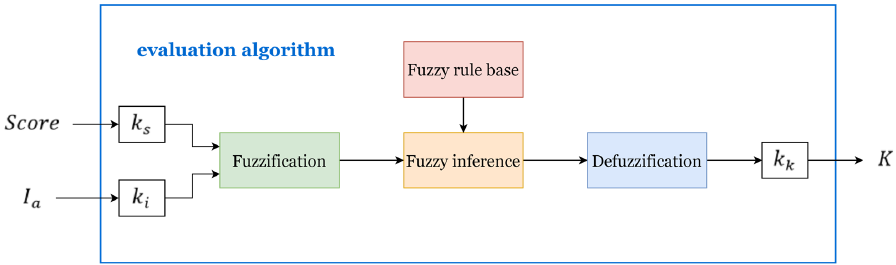
Figure 5. Fuzzy inference system structure diagram.